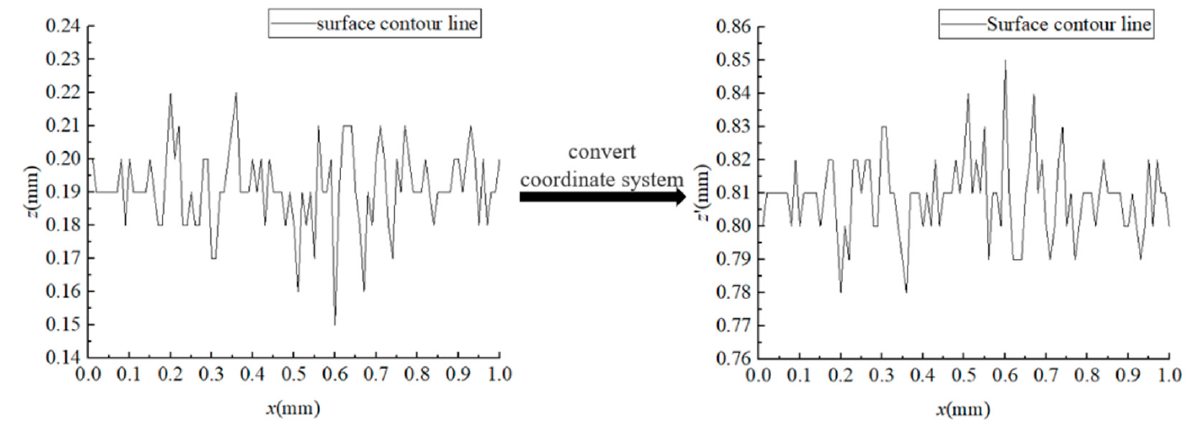
Figure 6. Schematic diagram of the coordinate transformation of slices.